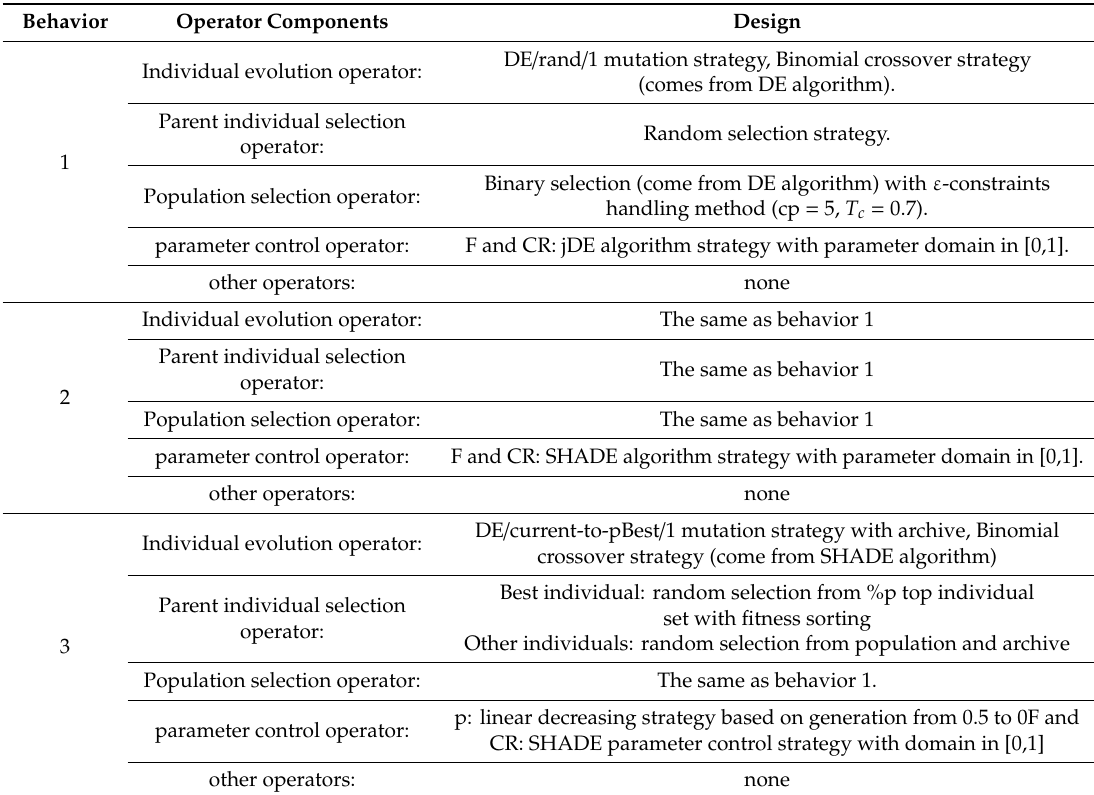
Table 3. The multi-behavior design with operators.